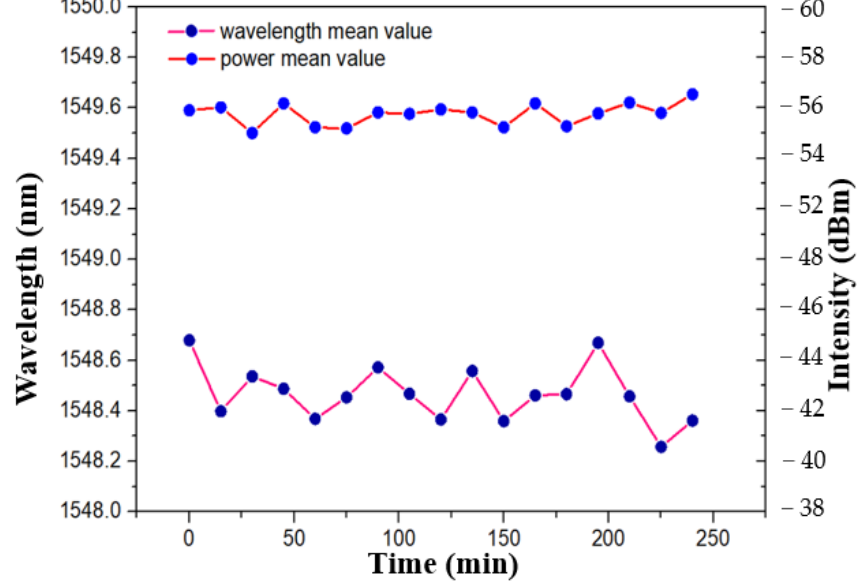
Figure 17. Test for time stability of wavelength shift and power fluctuation (at 51°).